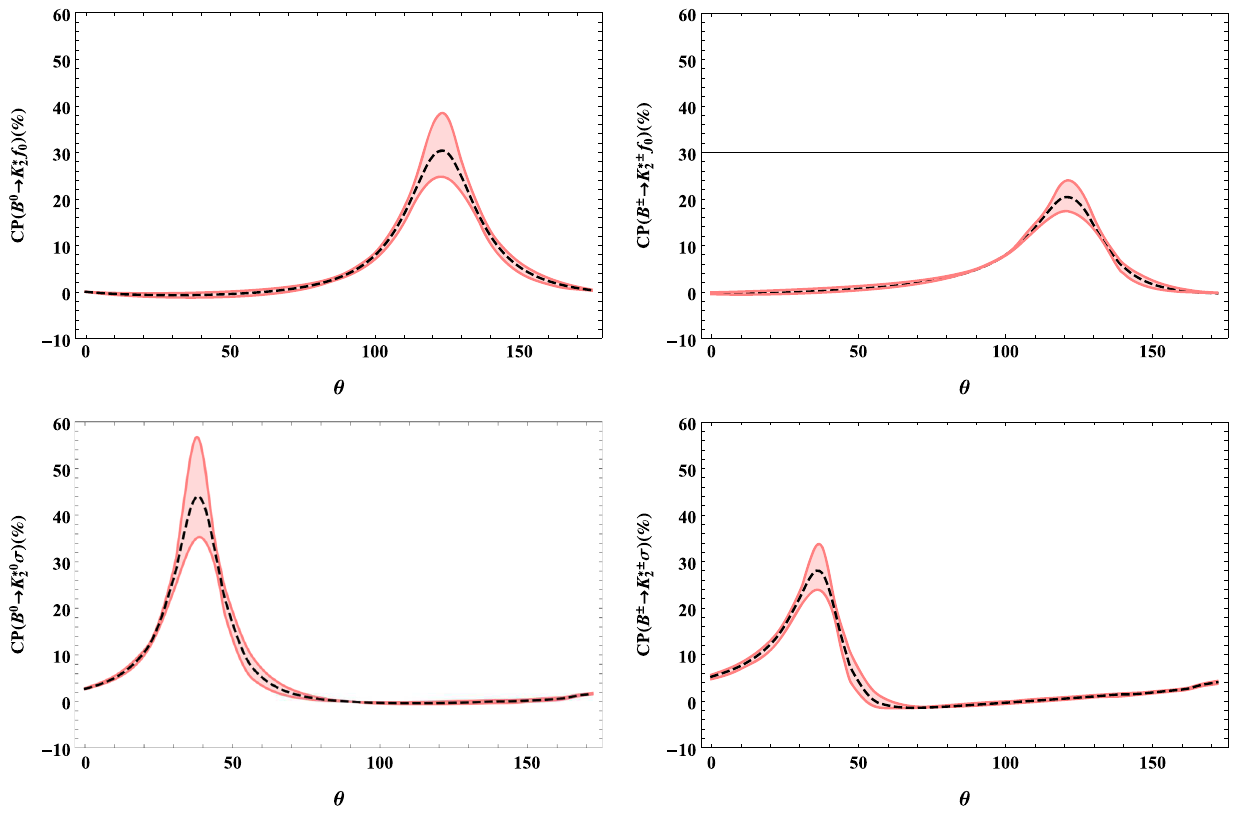
σ with variant of the mixing angle f 0 and B → K ∗ 2 2